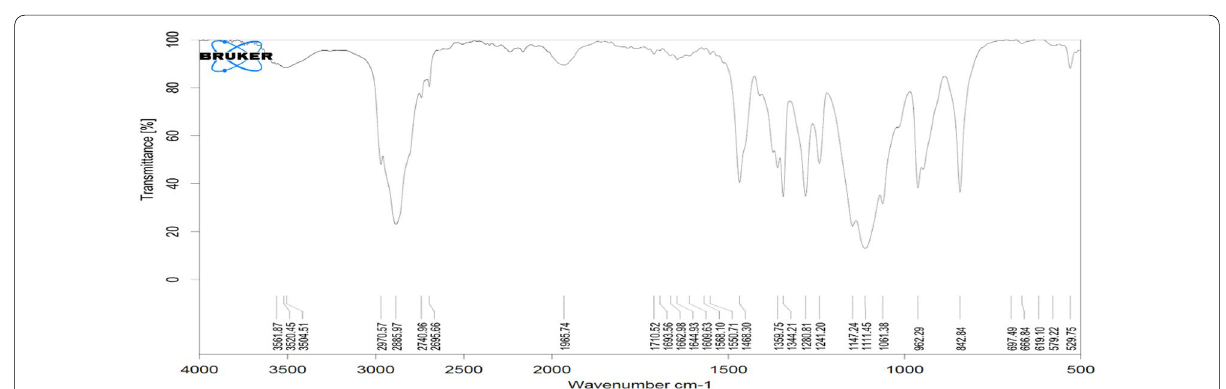
Fig. 3 FTIR spectra of A Chitosan B Pirfenidone